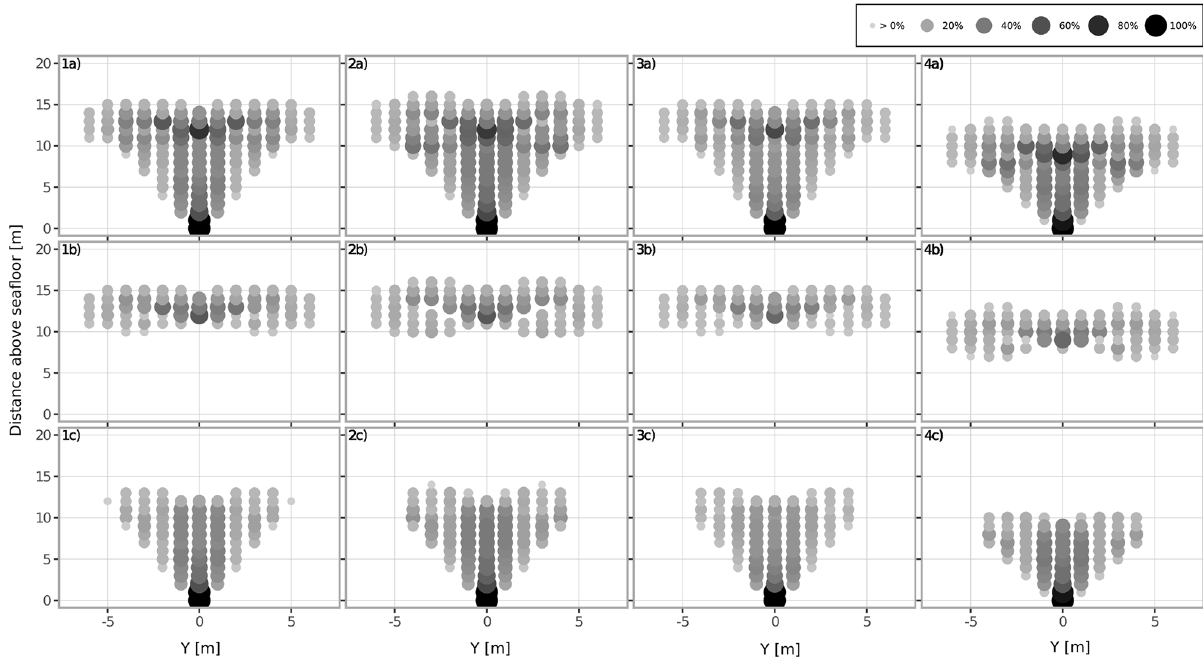
Fig 2. Probability (%) of a collision at each position in the cross-section between an animal and the a) entire structure, b) the kite, only and c) the tether, only for different configurations. Columnsrepresent the four different cases describedin the main text; 1) baseline,2) variationof kite trajectory, 3) longerkite periodand 4) increasedflight depth.